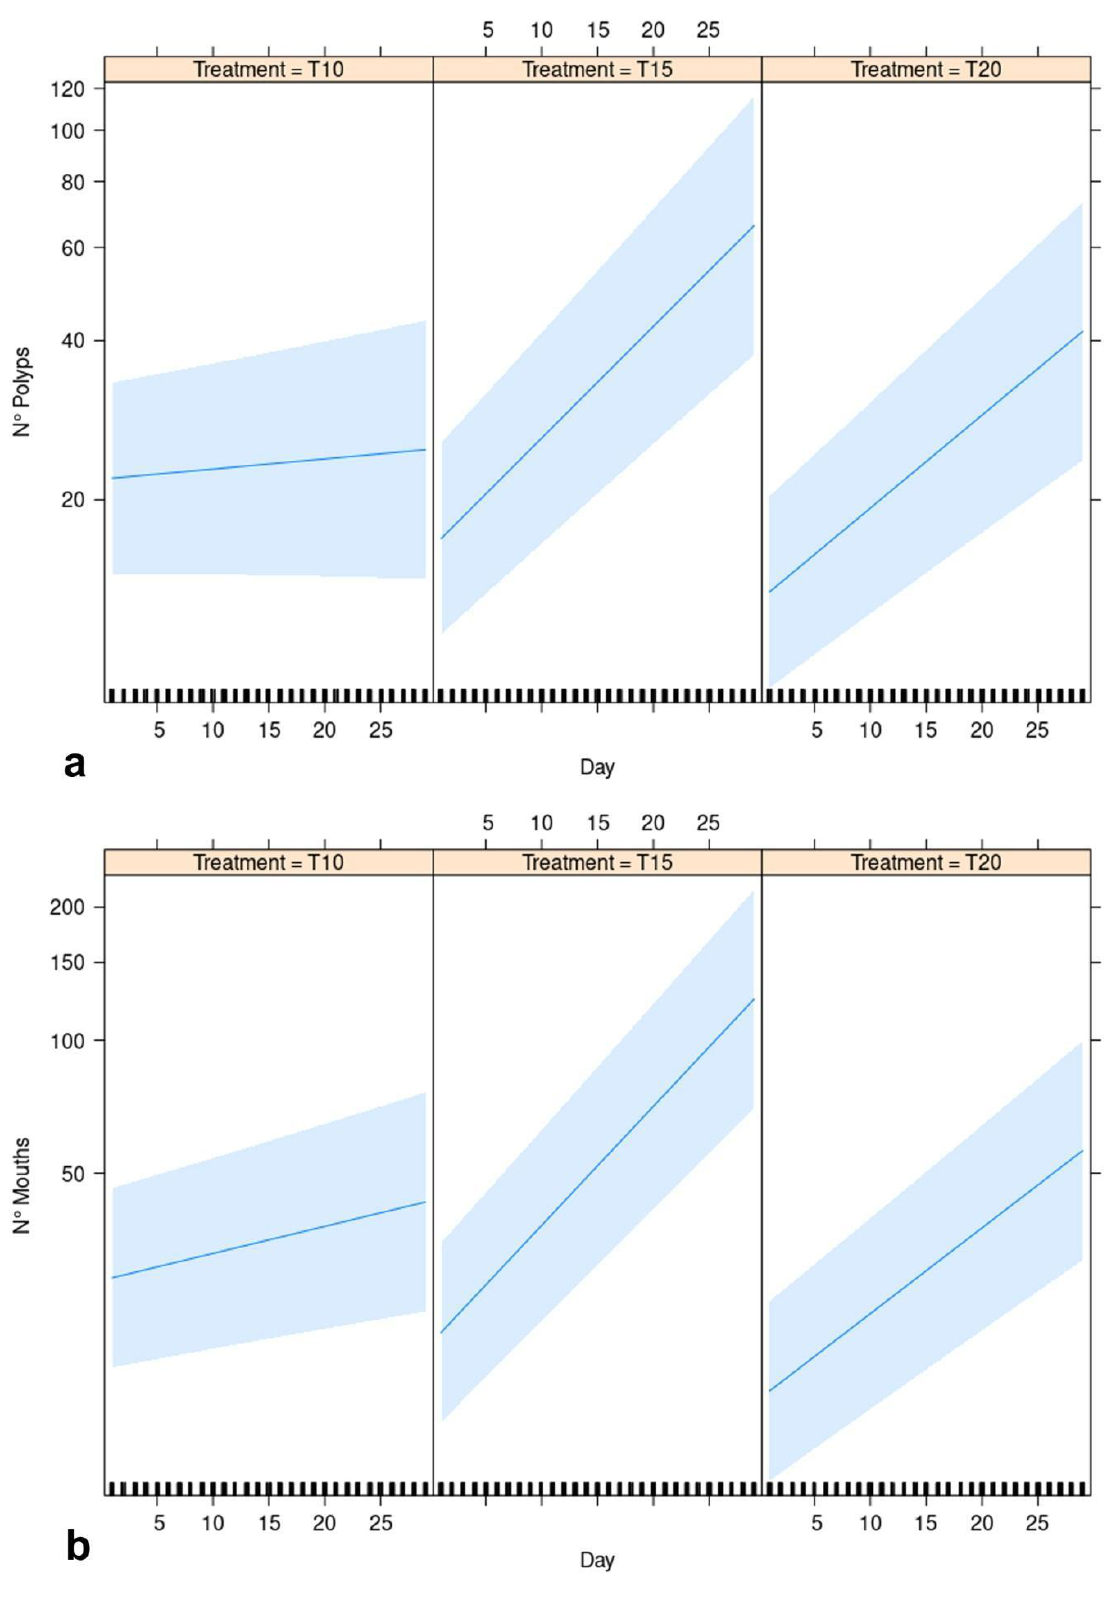
Figure 4. GLMM effect plot of estimated linear responses of ( a ) No. of polyps and ( b ) No. of mouths (both as response variables) for each level of the treatment (T10, T15 and T20).